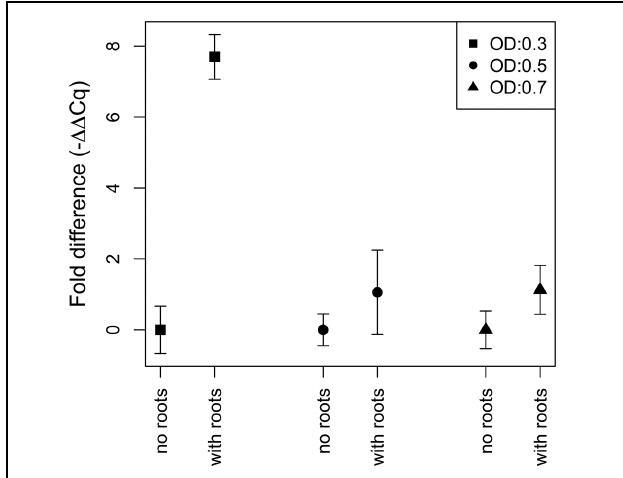
FIGURE 6 | Fold difference in expression of nifH after cells have been exposed to R. mangle roots. The different symbols represent different treatments at optical densities (OD) of 0.3 (square), 0.5 (circle), and 0.7 (triangle). The only significant increase of nifH expression is during the exponential phase (OD: 0.3) at the presence of mangrove